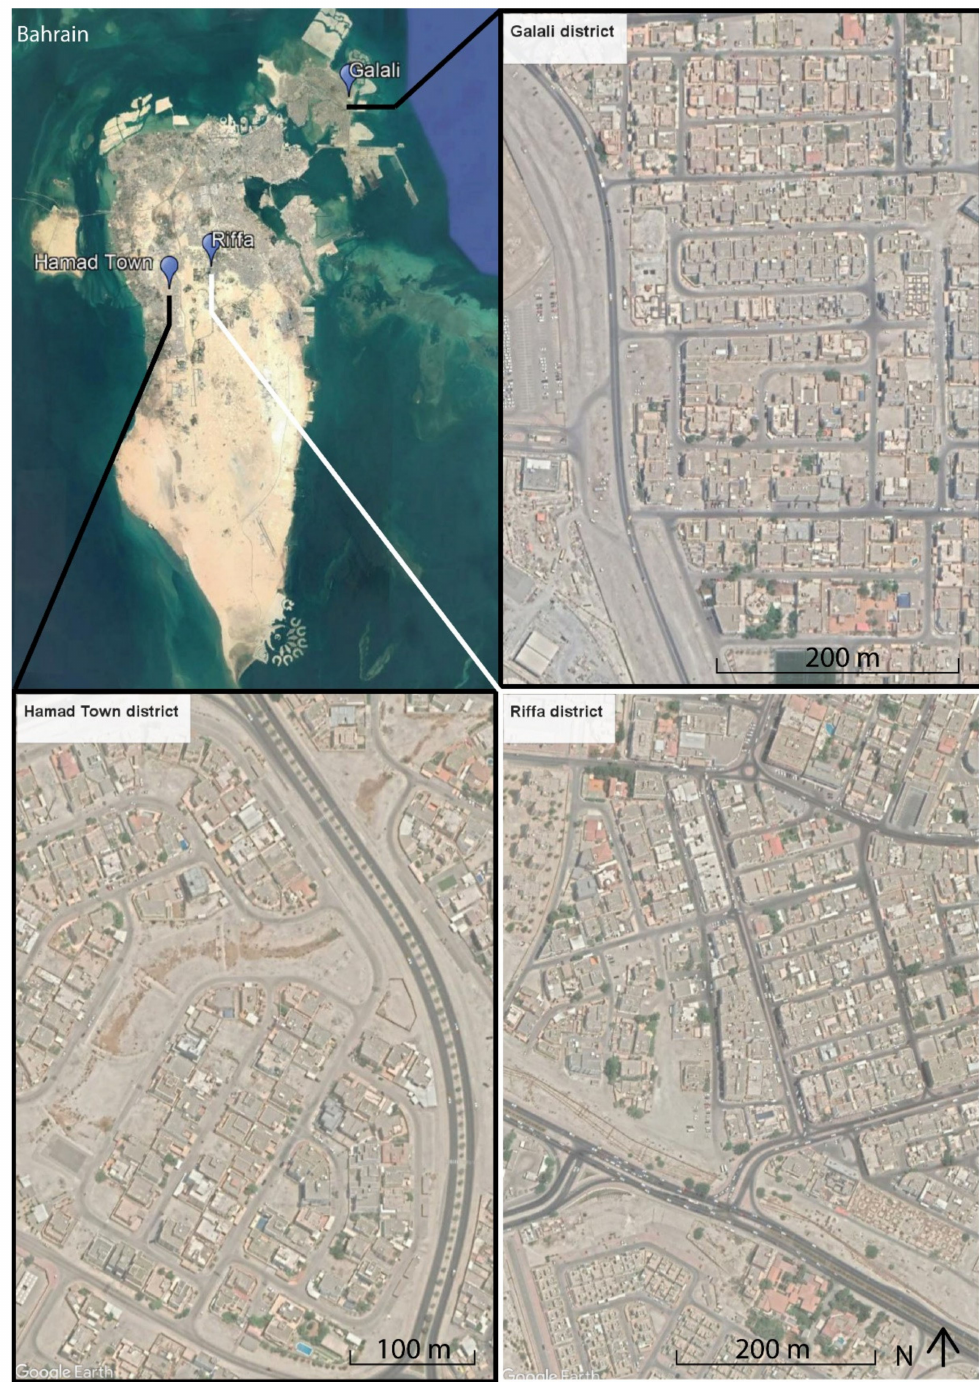
Figure 3. Representativeness of the square-shaped, reinforced concrete case study house across different residential areas in